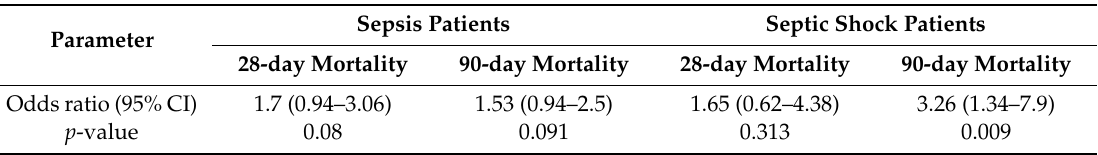
Table 4. Adjusted odds ratios for blood type O in predicting 28- and 90-day mortalities in sepsis and septic shock